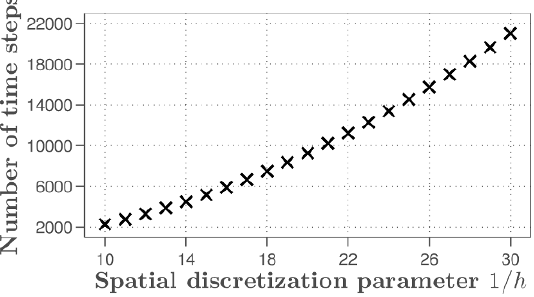
Figure 1. Number of steps N with step length τ = 1 s until Assumption 3 is satisfied vs. the number n of the grid points on the interval I = 1 cm.